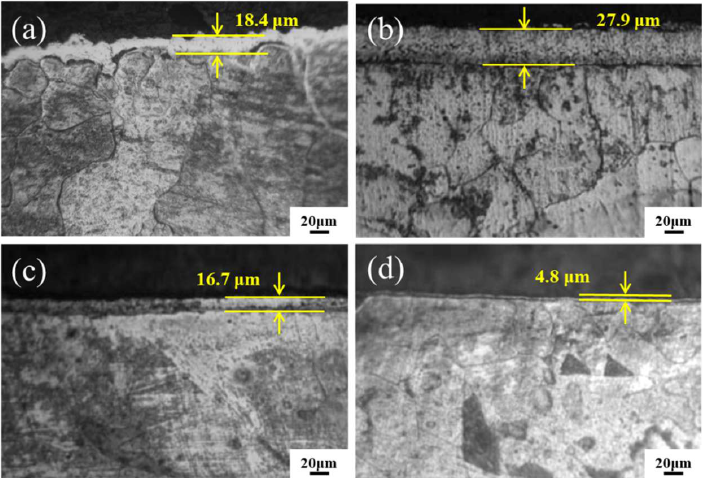
Figure 7. The cross-sectional MM images of Fe-Al-Cr alloyed layers under different electrode distances: ( a ) 10 mm; ( b ) 15 mm; ( c ) 20 mm; ( d ) 25 mm.